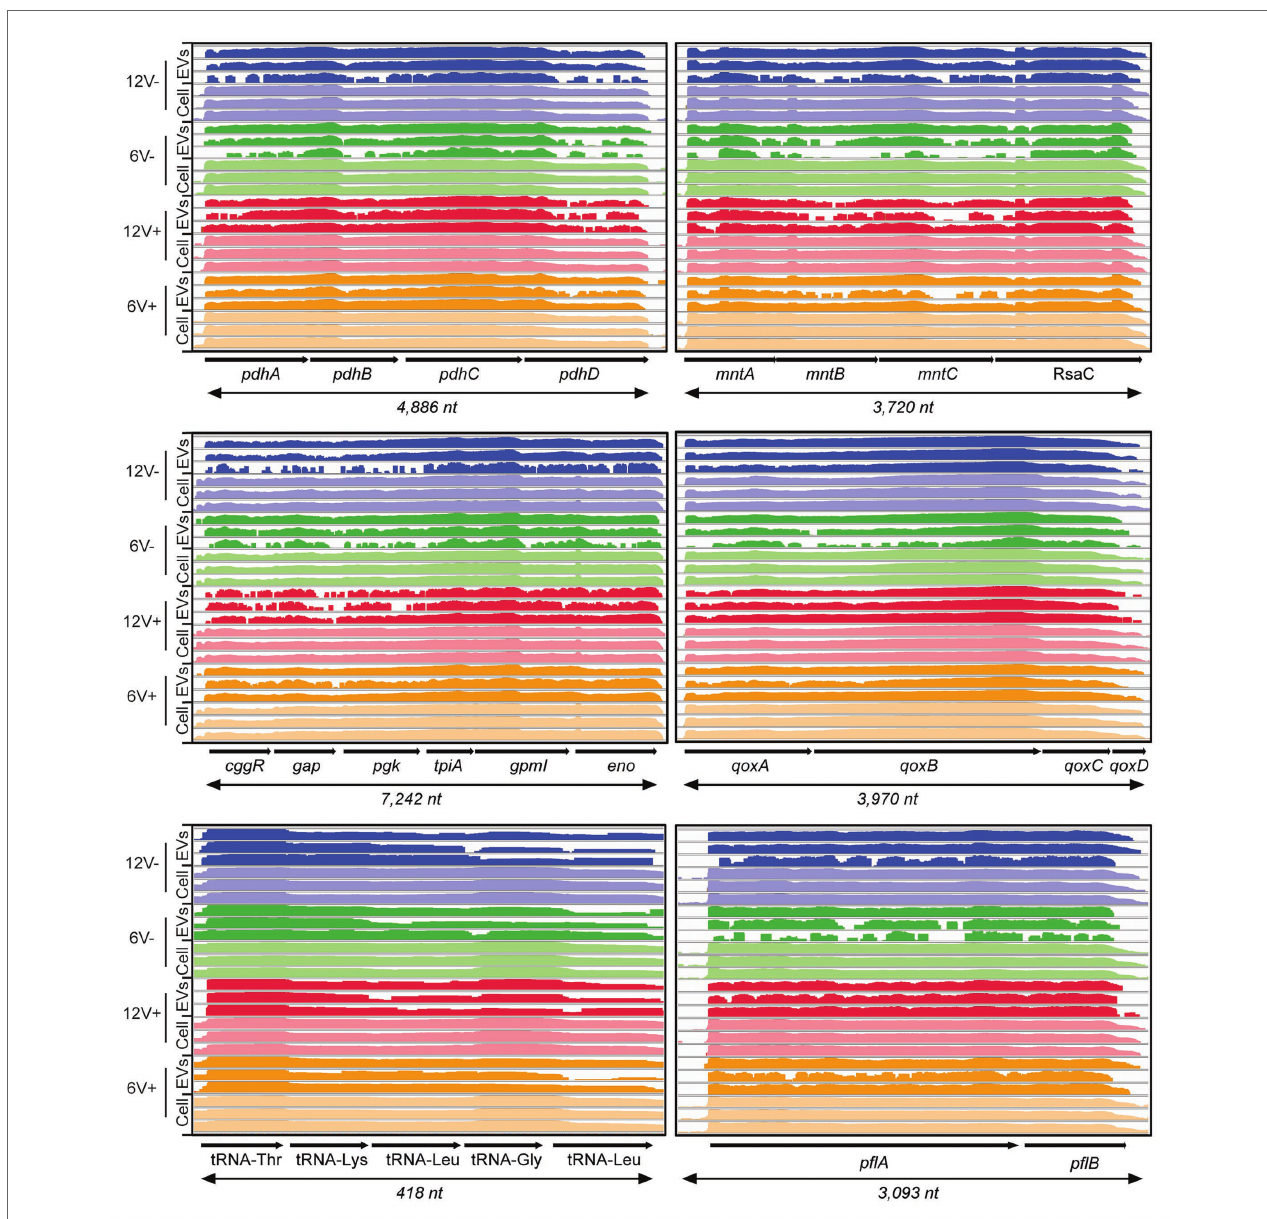
FIGURE 6 | HG003 EVs contain long mRNA transcripts. Comparison between operon coverages between EV-producing cell and EV samples in different conditions. Early- and late-stationary growth phases (6 and 12, respectively) in absence (V-) or presence (V+) of vancomycin. RNA coverage is visualized with Integrative Viewer Software (IGV) in log